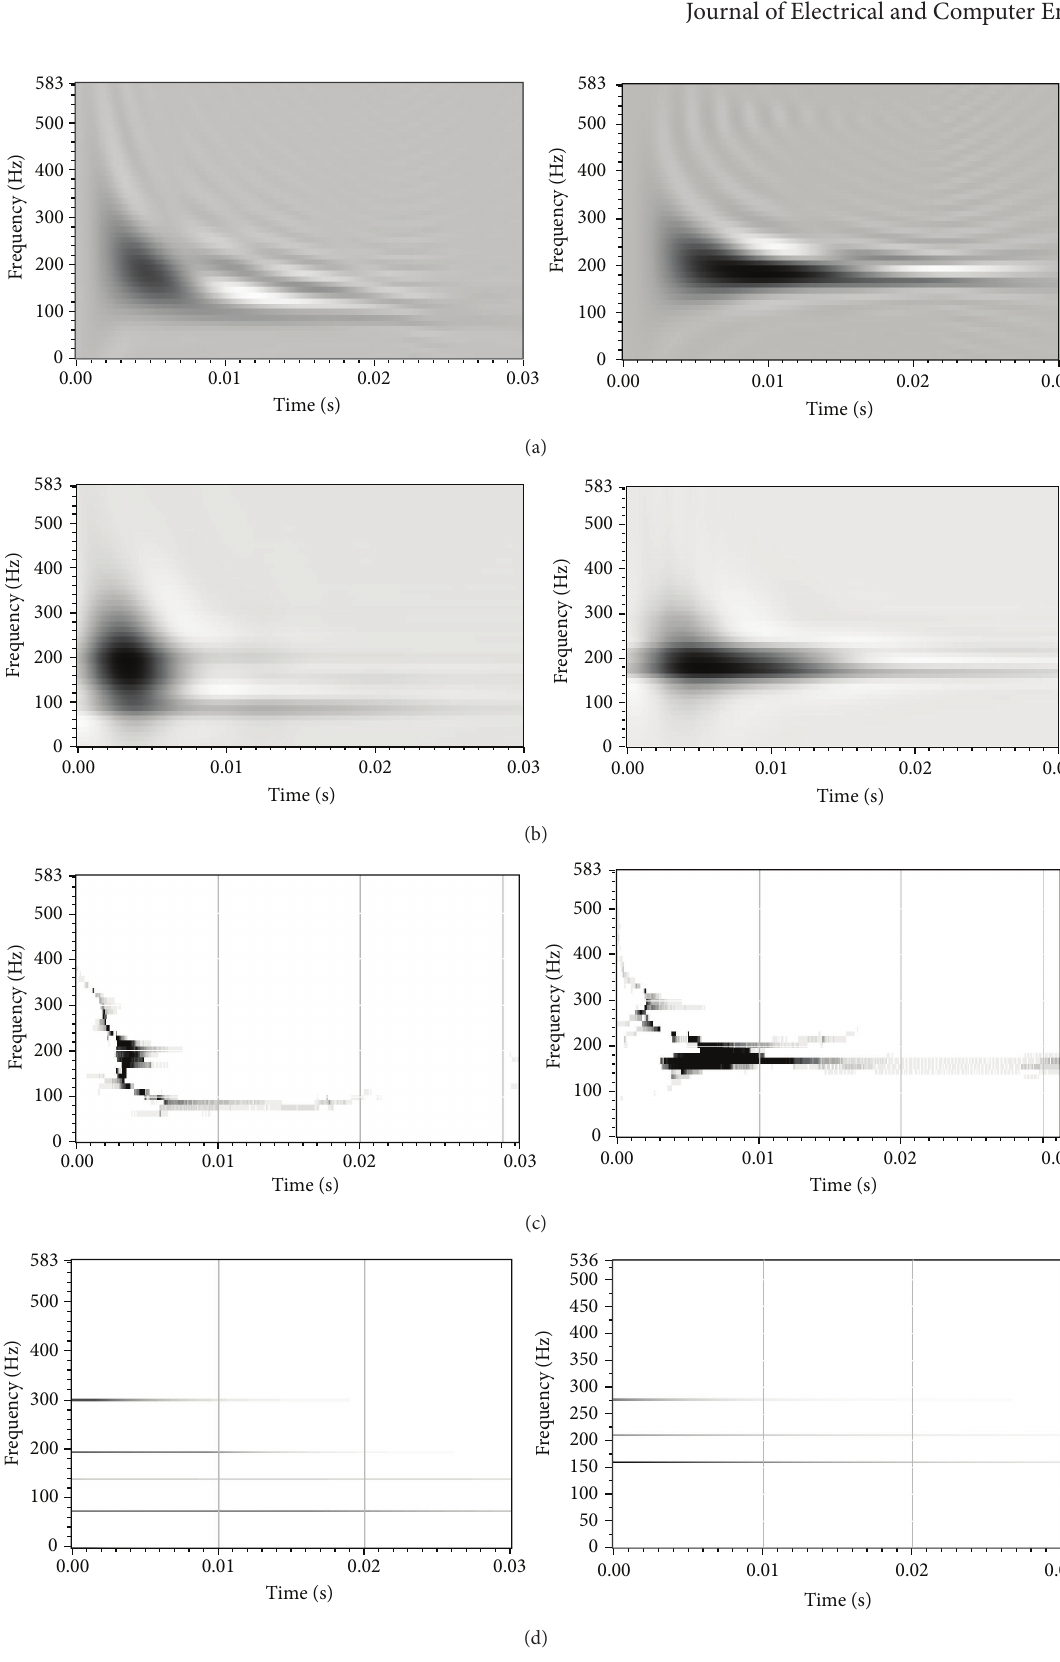
Figure 4: Time-frequency representations of the ideal, noise-free “resonant” (left) and “tympanic” (right) percussion signals shown in Figure 3. The “resonant” signal is a sum of four EDS; the “tympanic” signal is a sum of three EDS. (a) WVD; (b) CWD ( 𝛼 = 0.8 ); (c) STFT (spectrograms) taken with 1400-point Gaussian window; (d) MPM TFR (amplitudes of the original EDS comprising both